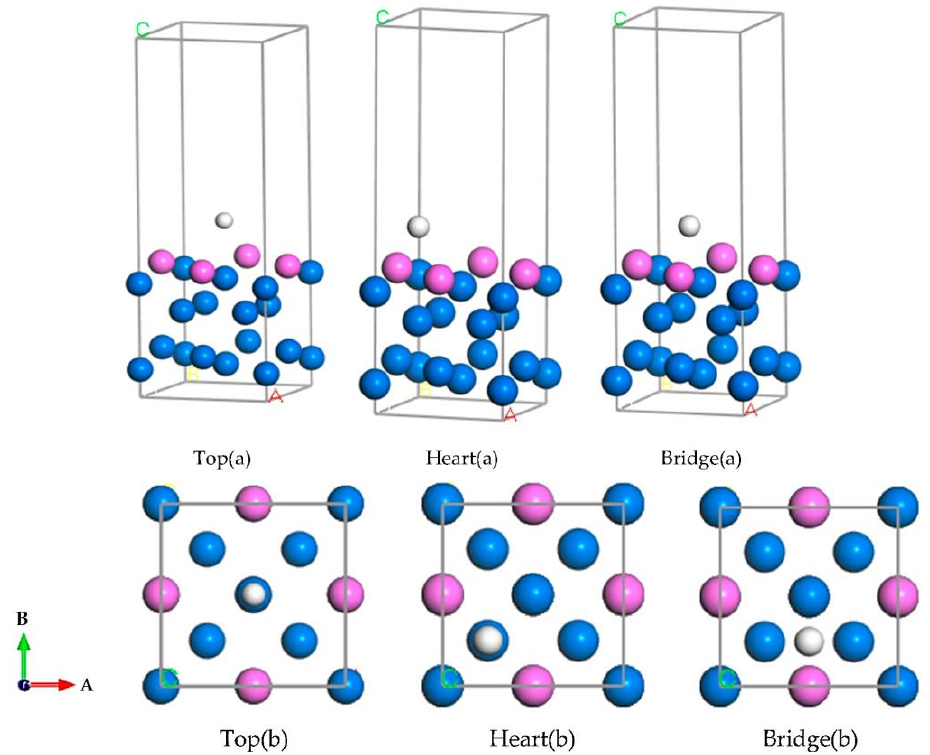
Figure 5. Different initial adsorption configurations of H on the surface of the plutonium-aluminum system ( a is an oblique view, b is a top view; The blue spheres represent plutonium atoms, the pink spheres represent aluminum atoms, the white spheres represent H atoms).